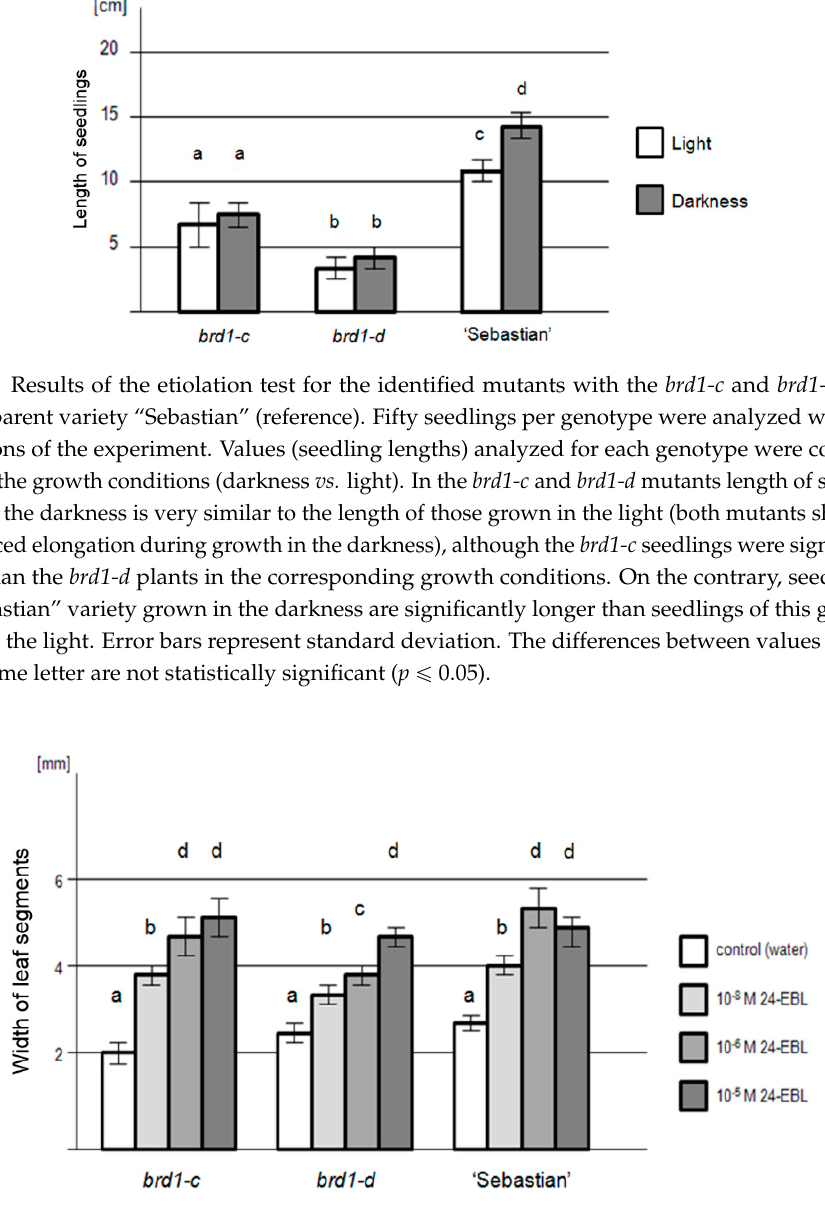
Figure 7. Results of the leaf-blade segment unrolling assay in response to various concentrations of 24-EBL for the identified mutants with the brd1-c and brd1-d alleles and the parent variety “Sebastian”. Ten leaf-blade segments per genotype per 24-EBL concentration were assayed in three replications of the test. Values obtained for a given incubation condition (control and various concentrations of 24-EBL) were compared between genotypes. Width of the leaf segments is given in millimetres. Error bars represent standard deviation. The differences between values denoted by the same letter are not statistically significant ( p ≤ 0.05).